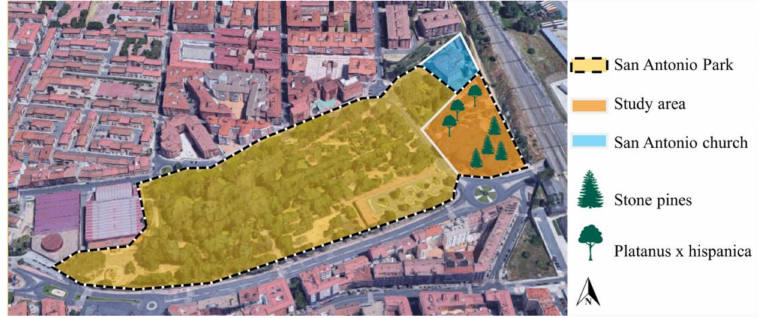
Figure 3. Delimitation of the first test site, the San Antonio Park, located in Á vila (Spain). Location: 40 ◦ 39 (cid:48) 31.4 (cid:48)(cid:48) N 4 ◦ 41 (cid:48) 4.23 (cid:48)(cid:48) W.